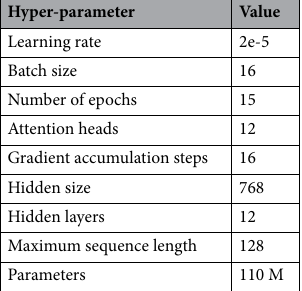
Table 5. mBERT model